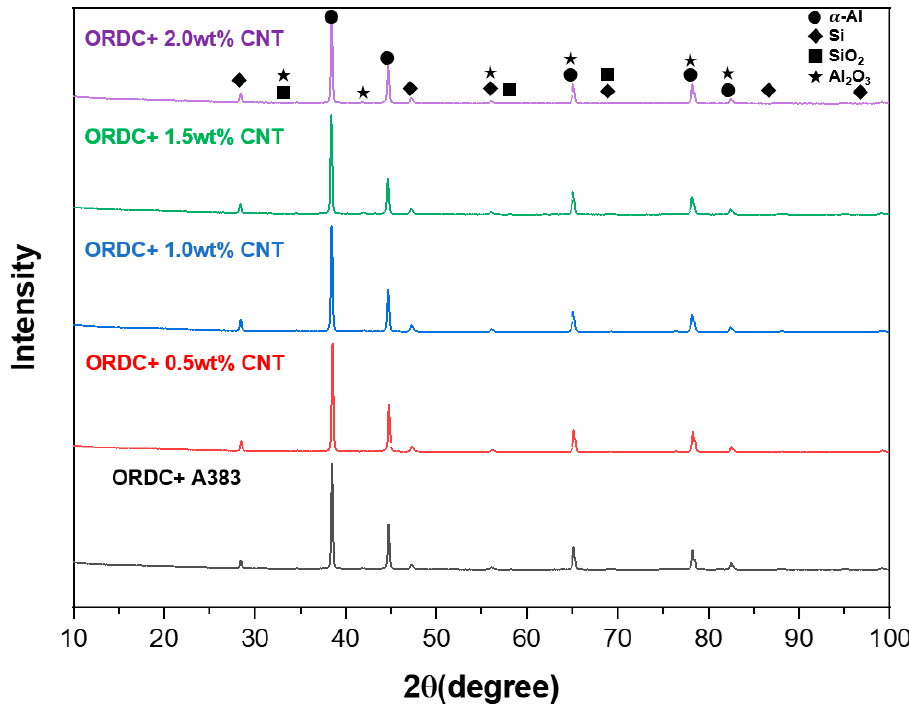
Figure 8. XRD patterns of A383 alloy and 0.5–2.0 wt% CNT-added composites.